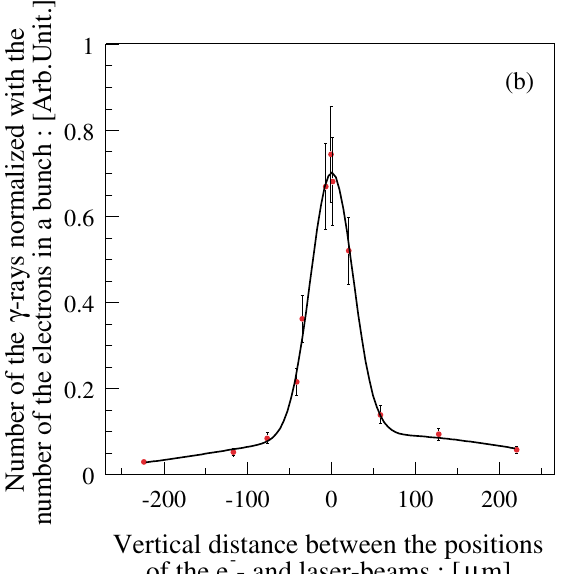
is (cid:1) i ), and the e i